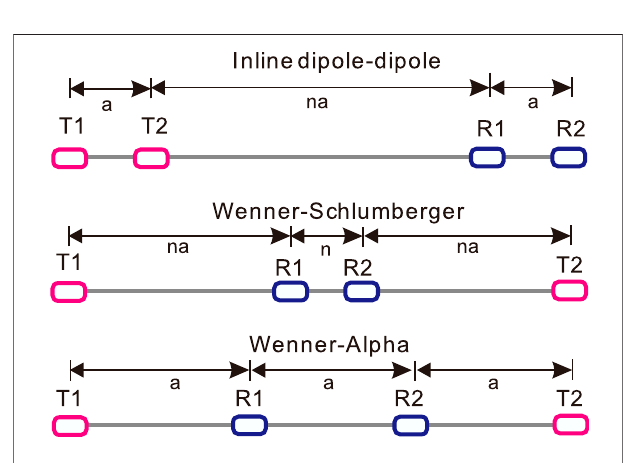
FIGURE 2 | The electrodes arrangement of various DCR array